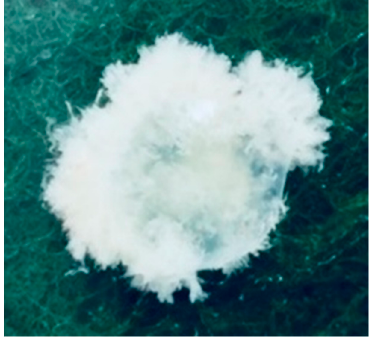
Figure 6. Chorionic villi at 7 w 5 d (30 × 27 mm).